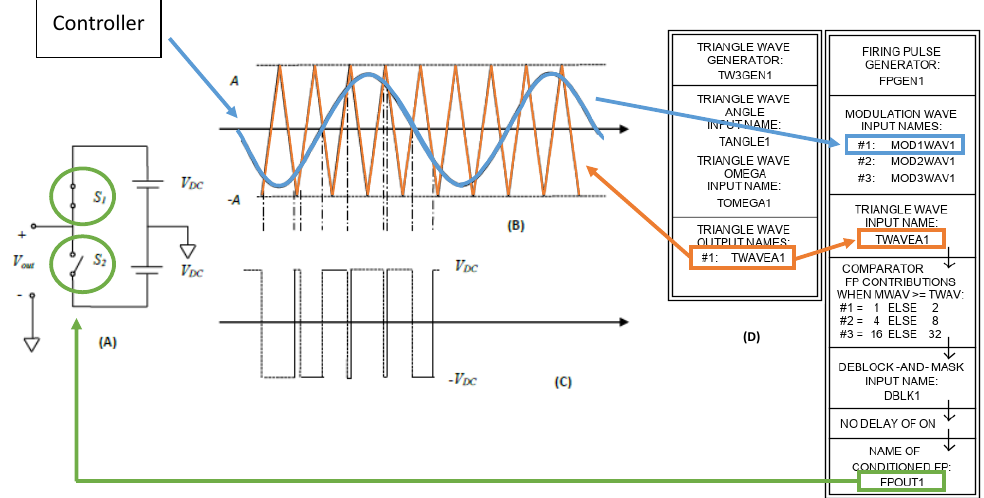
Figure 1. PWM in RSCAD—( A ) Two-switch system ( B ) Triangular and modulation waves ( C ) Output voltage ( D ) Triangular wave and firing pulse generators in RSCAD .dft file (Adapted from [19], credit to RTDS